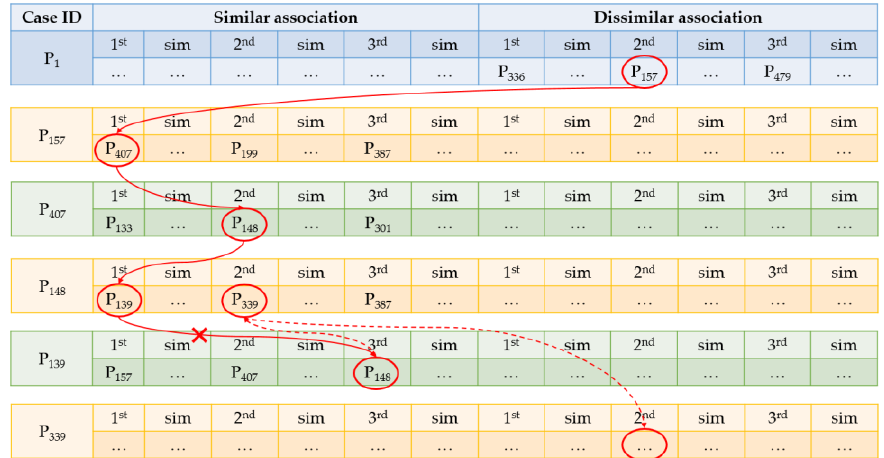
Figure 4. Travelling sequence of the proposed algorithm for the scenario in Figure